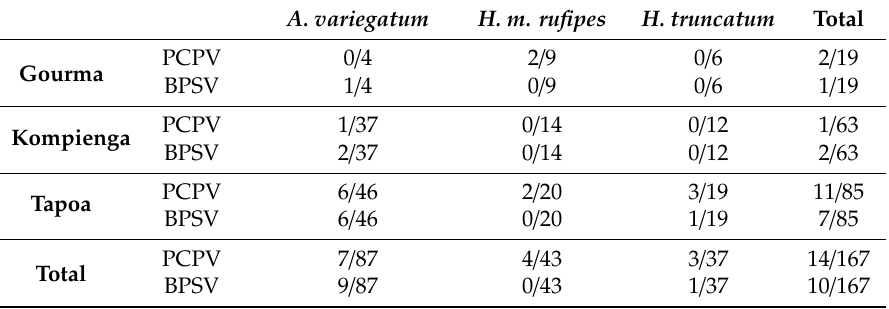
Table 3. Parapoxvirus detection in pools of ticks collected in each province of eastern Burkina